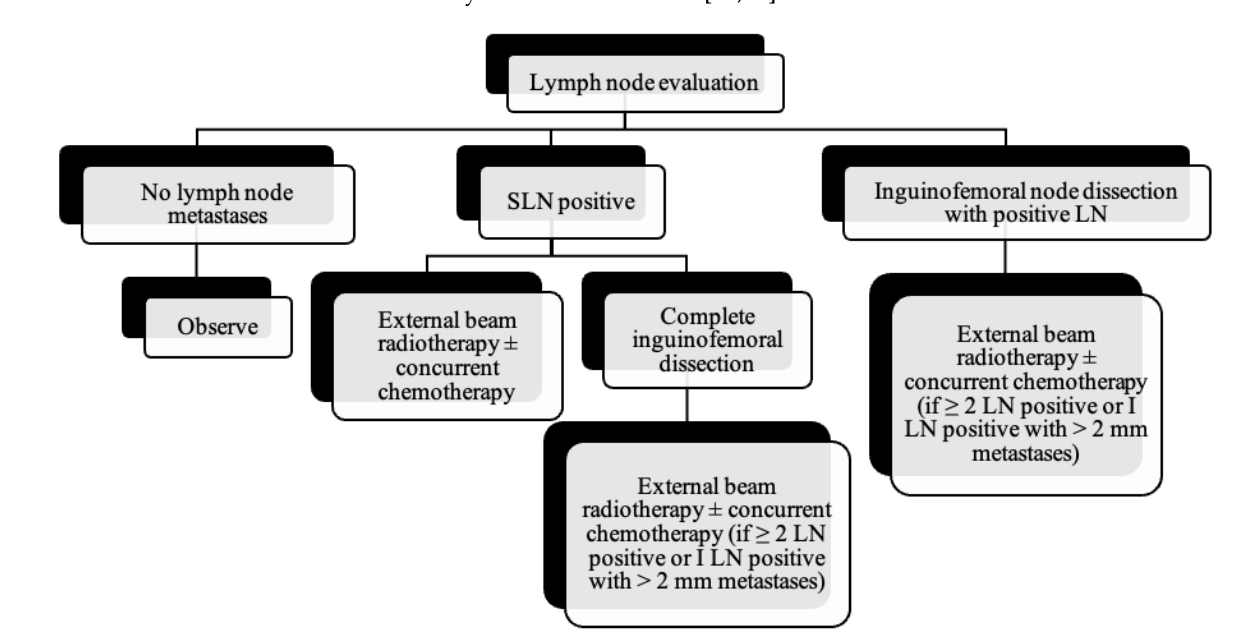
Figure 9. Post-surgical surveillance of vulvar cancer.